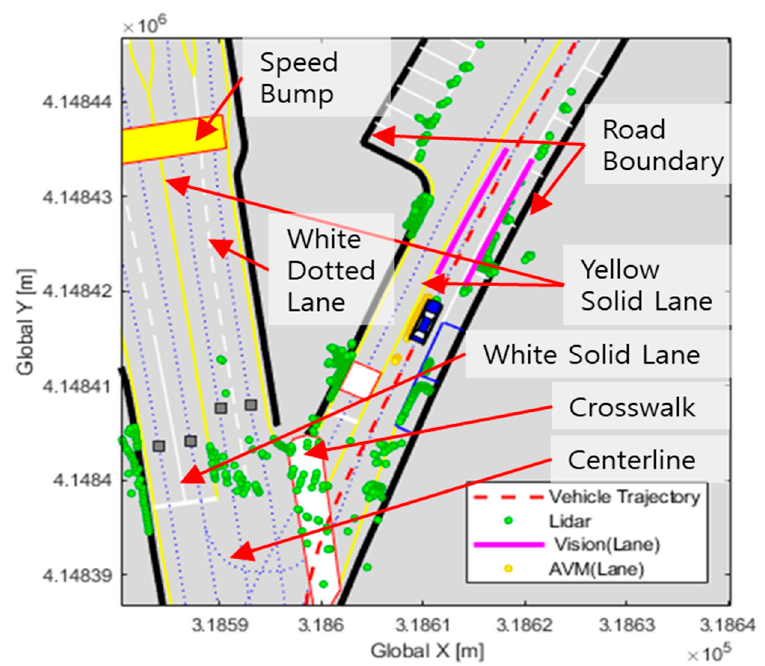
Figure 4. Major characteristics of an HD map: estimate current vehicle position with a variety of road information such as road curvature.